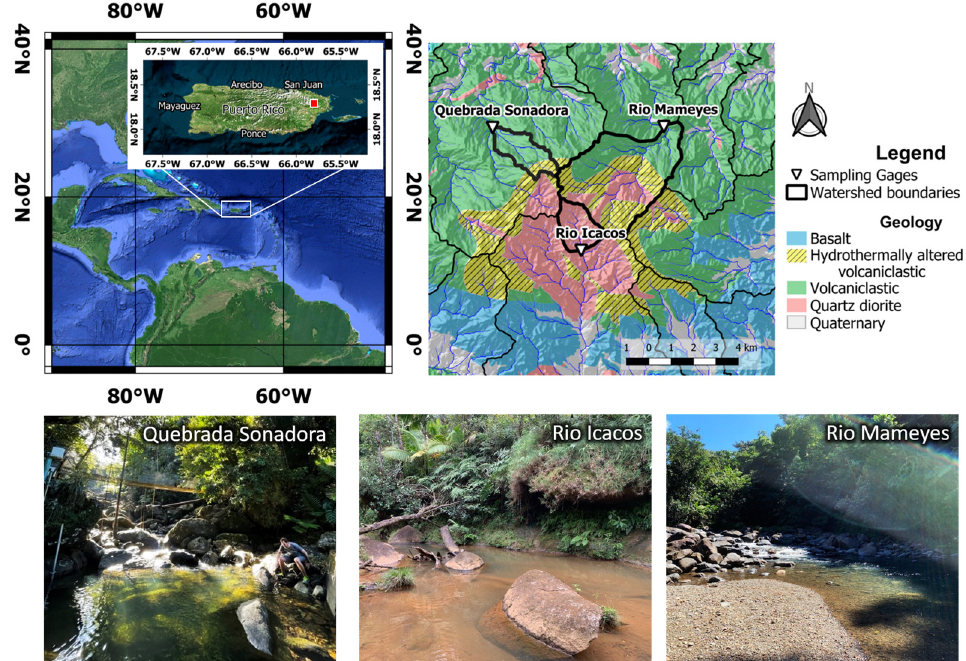
Figure 1. Location, geology, and representative pictures (at low flow) of the studied watersheds. Red square on inset map corresponds to the area on the geologic map (Geology based on Seiders et al [32]).